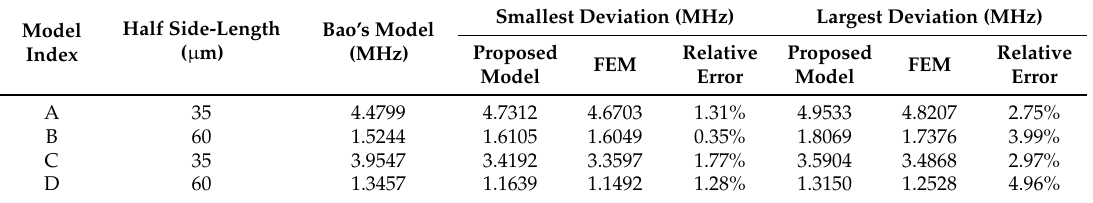
Table 4. Response frequency error analyses of three-layer CMUT membranes for different external